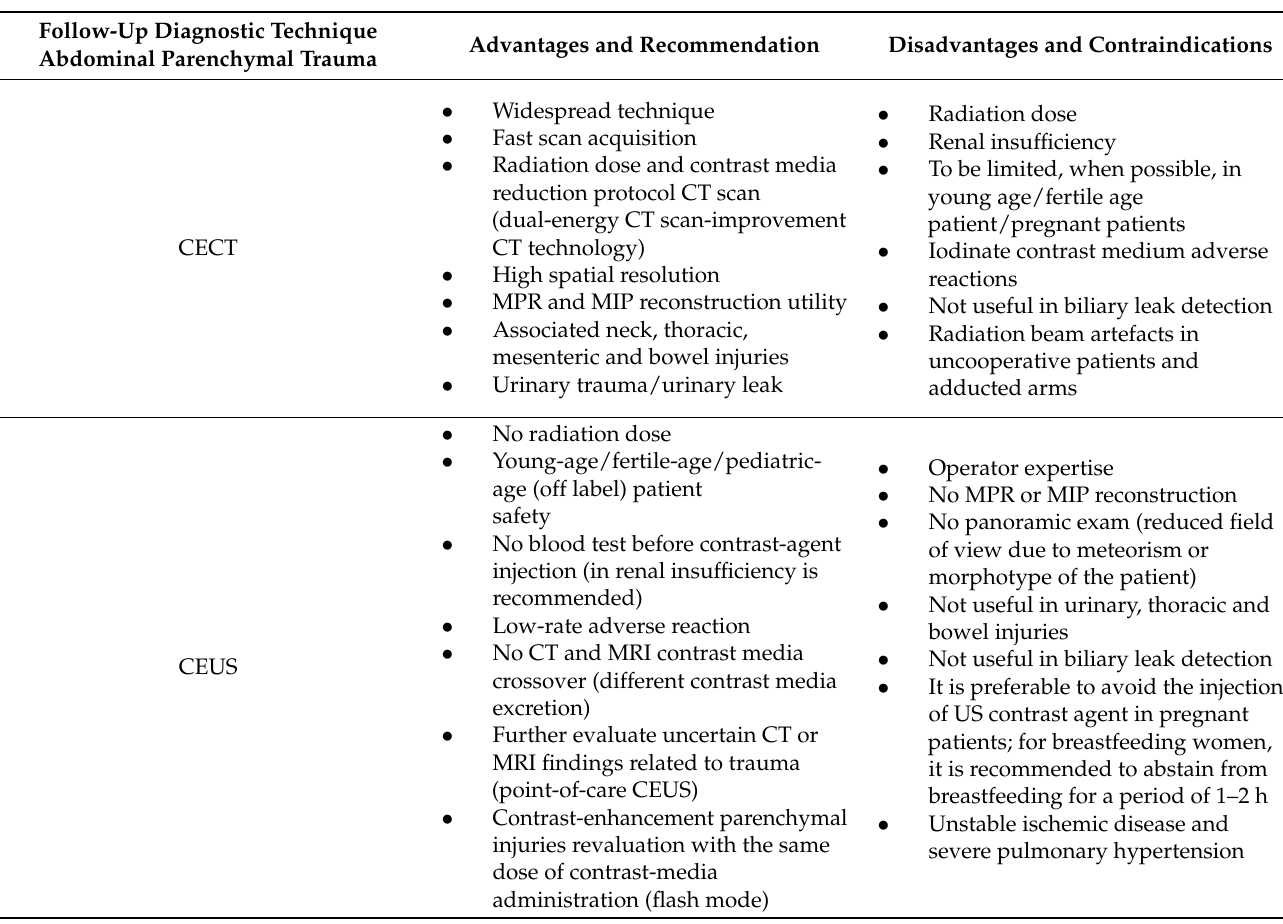
Table 1. Advantages and recommendations, and disadvantages and contraindications of the imaging technique that can be adopted in the follow-up of polytraumatized patients [41,45]. CECT (contrast enhanced CT); CEMRI (contrast enhanced MRI); MPR (multiplanar reconstruction); MIP (maximum intensity